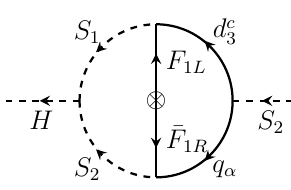
Figure 7 . Two-loop diagram that generates an in(cid:12)nite contribution to the soft term HS 2 . Note that this diagram is built directly from the one-loop bottom quark mass (cid:12)gure 1 (left) by closing the fermion lines. This diagram implies that once the soft term (cid:22) F 1 R F 1 L ( be included too. If not, the resulting theory would not be